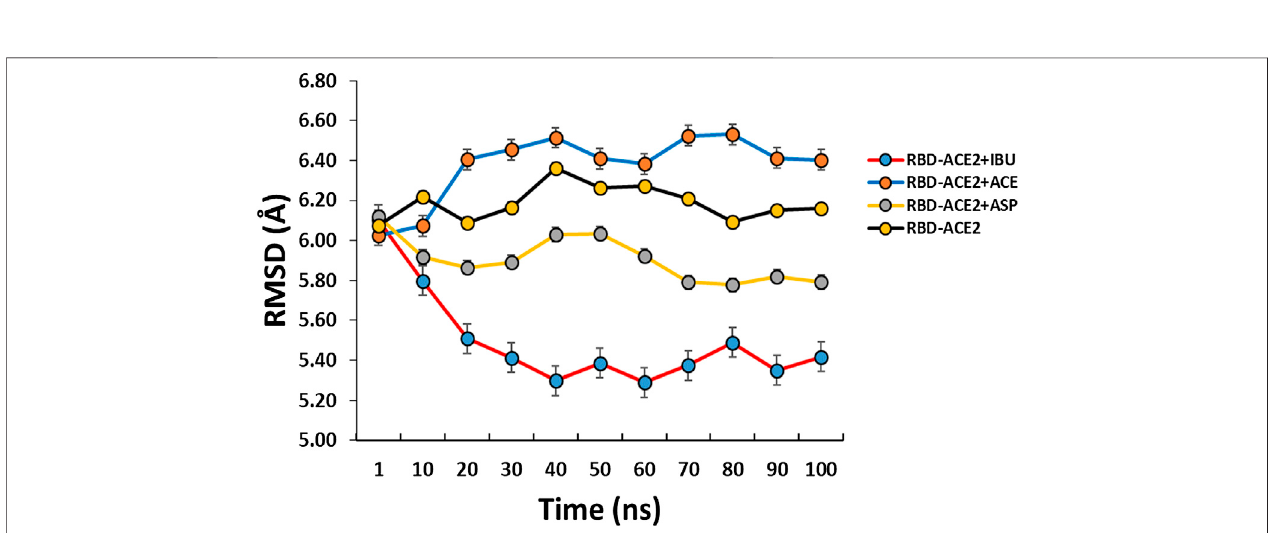
FIGURE 4 | Conformational fl uctuation and partial unfolding or folding of RBD-ACE2 protein complex in presence of Ibuprofen (RBD-ACE2+IBU), Aspirin (RBD- ACE2+ASP) and Acetaminophen (RBD-ACE2+ACE) at 100 ns. As a control, RBD-ACE2 protein complex without ligands was simulated (RBD-ACE2). Using as a reference the distances between the residues of Glu19(A) and Phe372(A). Arbitrarily chosen because they are at a distance of approximately 6 Å from the ligands.